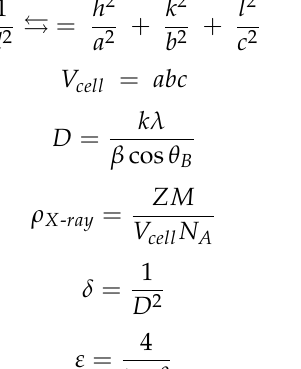
Figure 2. Bi 2 S 3 thin films that have been Cr-doped and left undoped show various XRD patterns. Lattice factors “ a , b , and c ”, unit cell volume “ V cell ”, Scherrer crystallite size “ D ” [44], X-ray density “ ρ X-ray ” dislocation density “ δ ”, and microstrain “ ε ” were calculated using Equations (1)–(6).